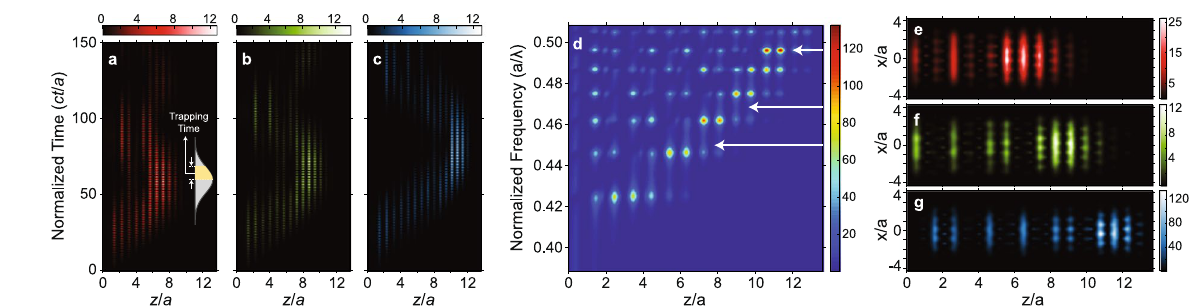
Figure 3. Instantaneous and steady-state field analysis. Time evolution of a Gaussian pulse propagating inside the 3D PhC (along the z- propagation direction, at the center of the xy - plane), for three frequencies: ( a ) a / λ = 0.450, ( b ) a / λ = 0.468 and ( c ) a / λ = 0.496. ( d ) Broadband steady-state field intensity distributions at the same propagation line. Steady-state field distributions obtained at the xz - plane of the center of the y - direction for the normalized operational frequencies equal to ( e ) a / λ = 0.450, ( f ) a / λ = 0.468 and ( g ) a / λ = 0.496. The magnitude of the field intensities are normalized by dividing the calculated intensities to the intensity produced by the source at the specific frequencies. The distances in the z- propagation direction are given with respect to the position of the